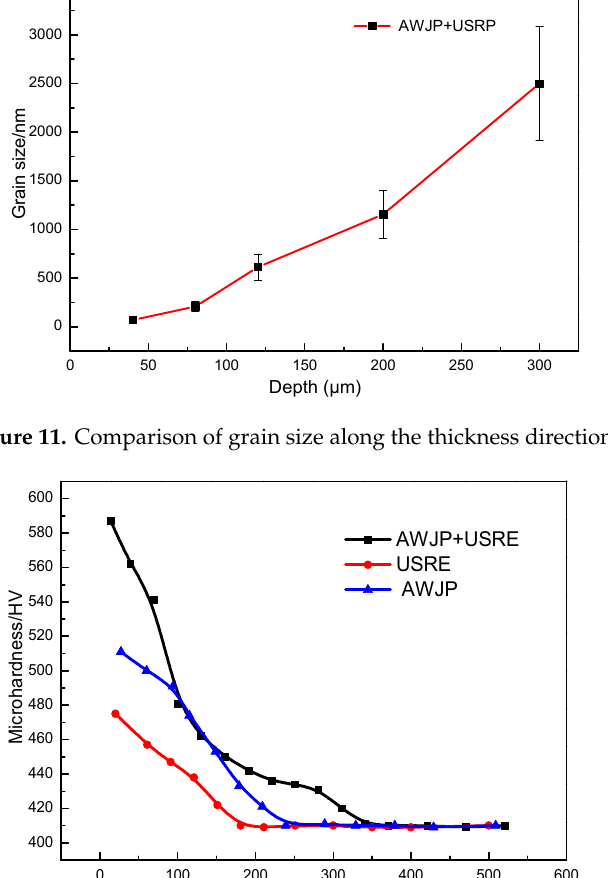
Figure 12. Comparison of microhardness along the thickness direction.